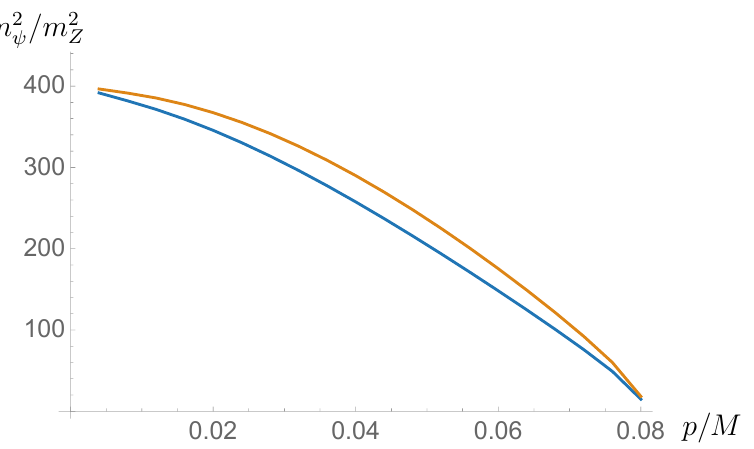
Figure 5 . The mass ratio m 2 =m 2 , plotted here for g s M = 10 (blue) and g s M = 100 (yellow), Z decreases for growing p=M , until the KPV vacuum is lost at p=M of O (10) O (100), being the heavier modulus. This does not change qualitatively for di(cid:11)erent (cid:0) values of g s M